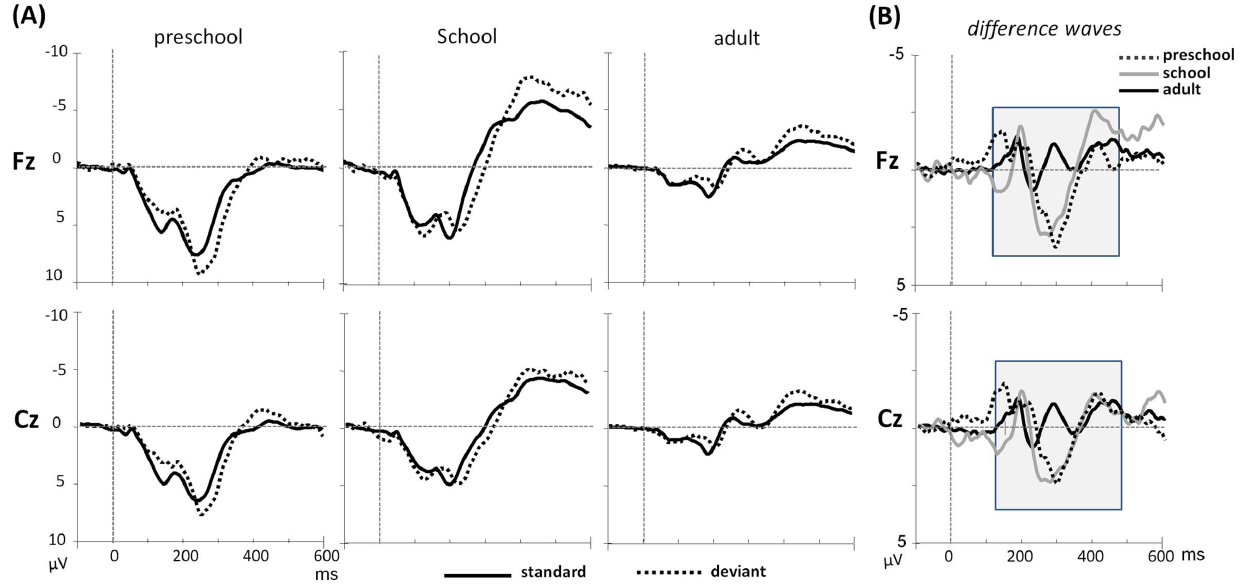
Figure 2. (A) Grand average waveforms of the standard and deviant stimuli at midline electrodes (Fz & Cz), and (B) difference waveforms across three age groups to consonant